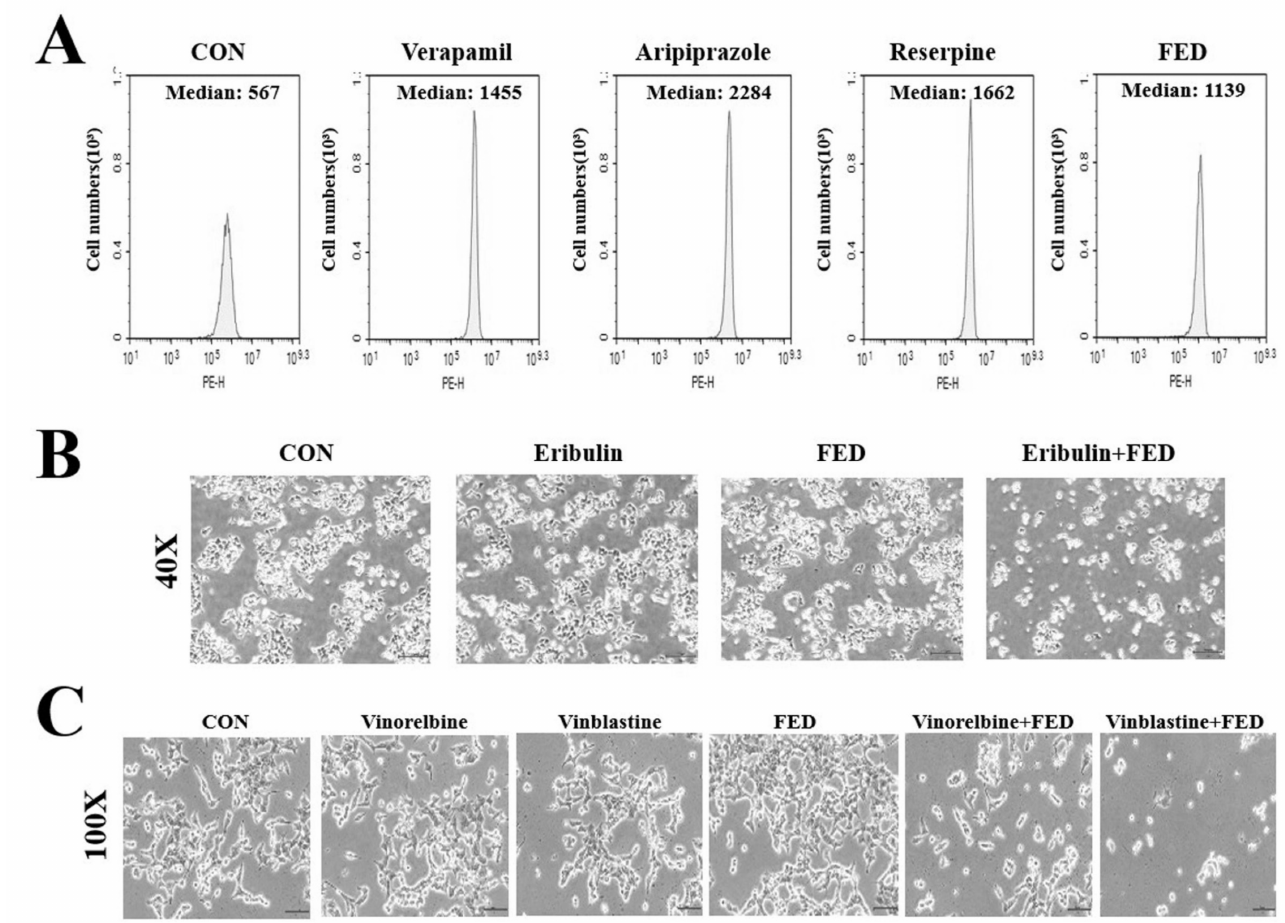
Figure 3. Fedratinib with P-gp inhibitory activity increases the sensitization of KBV20C cells treated to other anti-mitotic drugs. ( A ) KBV20C cells were grown on 60 mm-diameter dishes and treated with 10 µ M verapamil, 2.5 µ M aripiprazole, 5 µ M reserpine, 2 µ M fedratinib (FED), or 0.1% DMSO (CON). After 1 h, all cells were stained with rhodamine for 3 h and examined by using FACS analysis, as described in Section 4, Materials and Methods. ( B , C ) KBV20C cells were grown on 60 mm diameter dishes and treated with 30 nM eribulin, 0.1 µ g/mL vinorelbine, 5 nM vinblastine, 2 µ M fedratinib (FED), 30 nM eribulin with 2 µ M fedratinib (Eribulin + FED), 0.1 µ g/mL vinorelbine with 2 µ M fedratinib (Vinorelbine + FED), 5 nM vinblastine with 1 µ M fedratinib (Vinblastine + FED), or 0.1% DMSO (CON). After 1 day, all cells were observed using an inverted microscope at x40 or x100